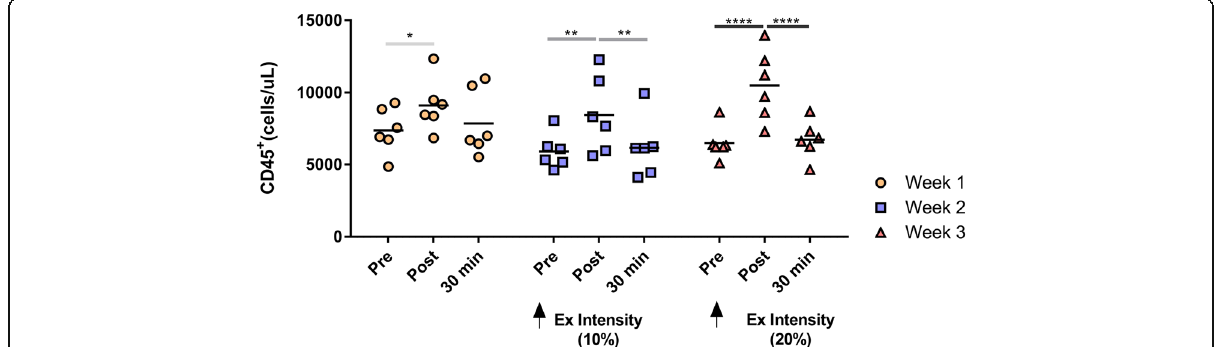
Fig. 10 Circulating numbers of CD45 + leukocytes during 3 weeks of exercise training ( N = 6). Significant effect of time was detected ( P < 0.0001). Post hoc Tukey ’ s adjusted significance: * P < 0.05, ** P < 0.01, **** P < 0.0001. No significant main effect of intensity or interaction was observed ( P > 0.05)